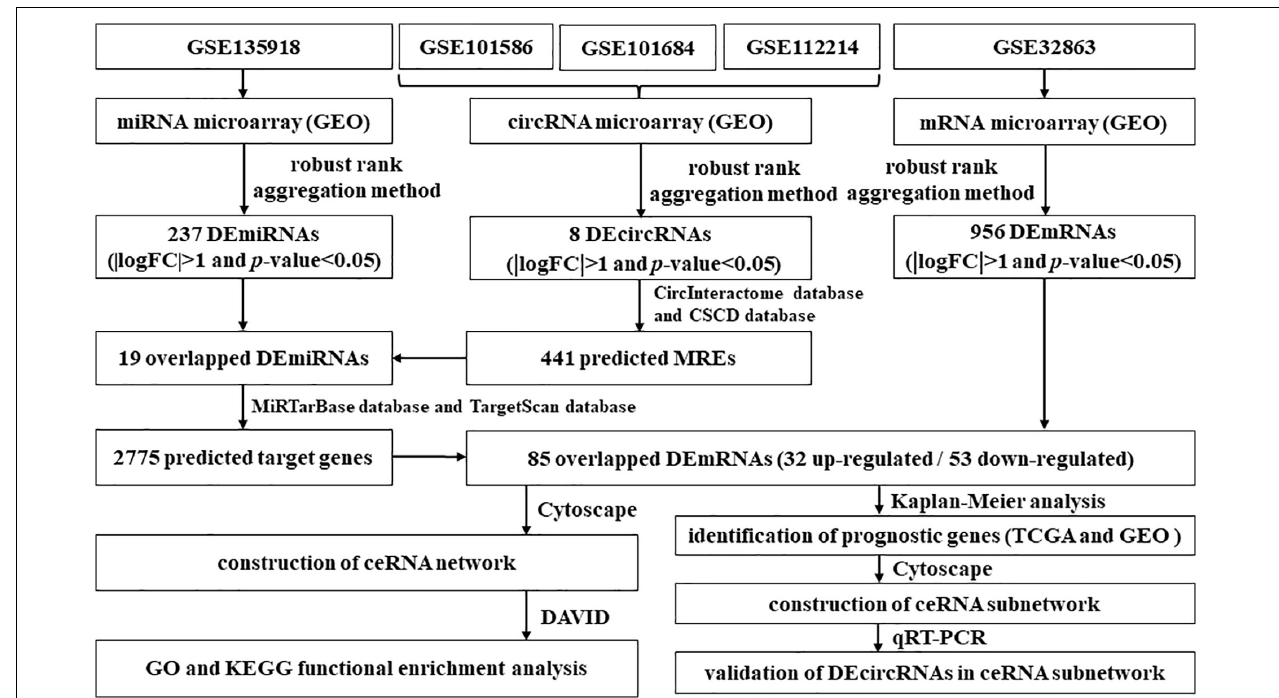
FIGURE 1 | Flowchart of the comprehensive analysis process and all methods utilized in present study.